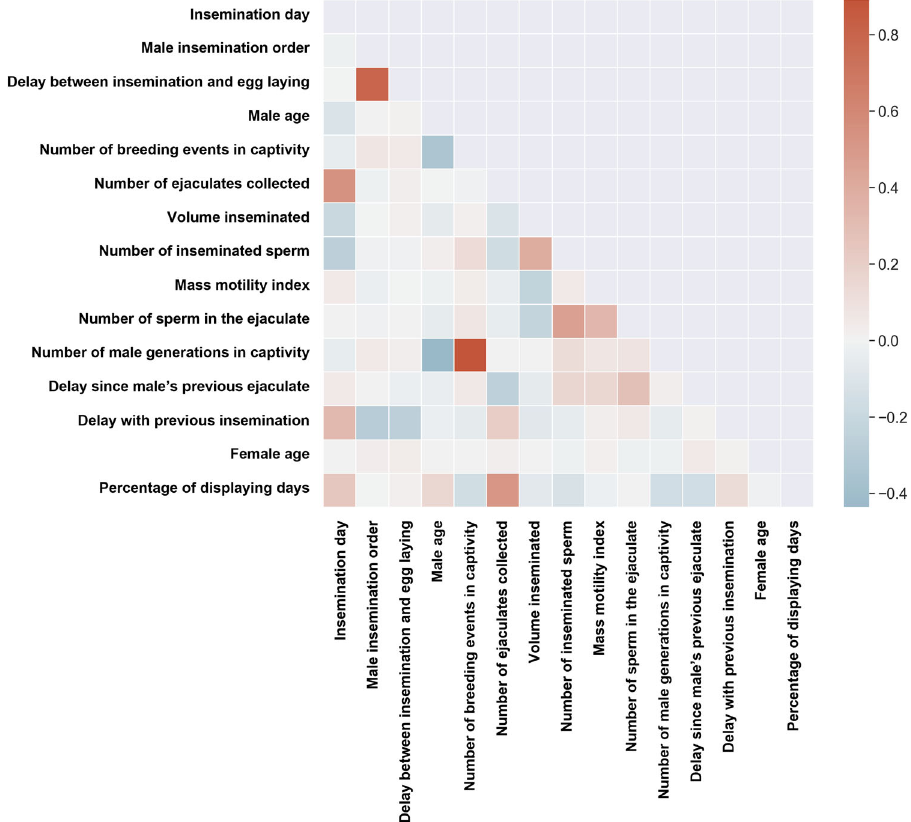
Fig. 3 Covariation between the predictors of siring success. Correlation heatmap (squares below the diagonal report the Pearson correlation coef fi cients) of the 15 predictors of siring success. N = 879 males and 599